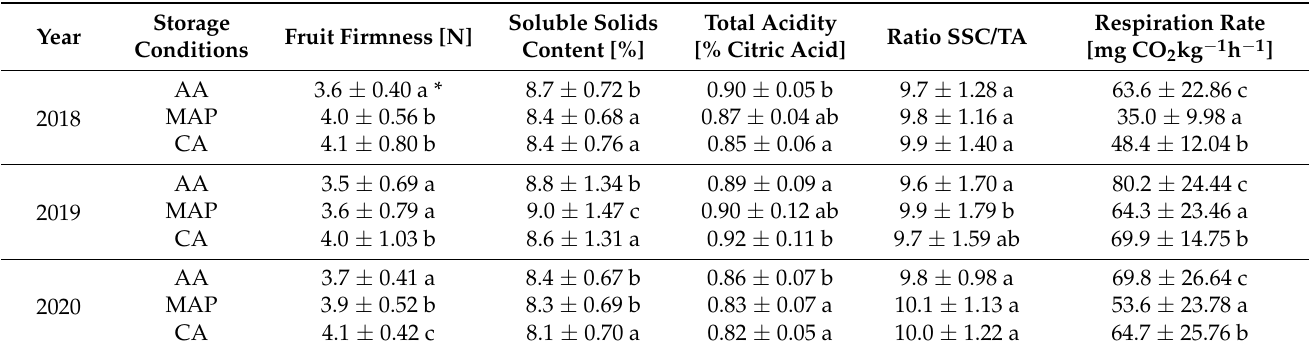
Table 4. Effect of storage conditions on the quality of ‘San Andreas’ strawberries and average for harvest dates.